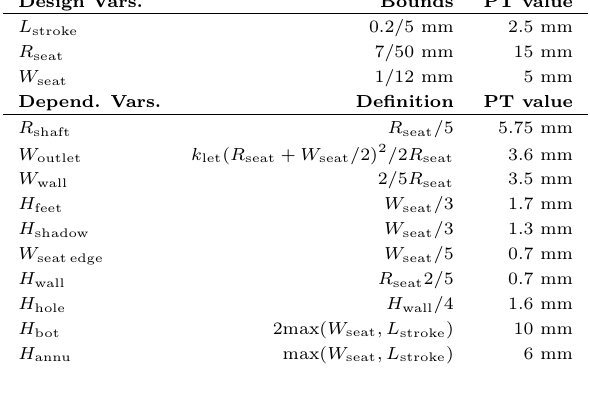
Table 1: Design variables with bounds and auxiliary variable definitions.